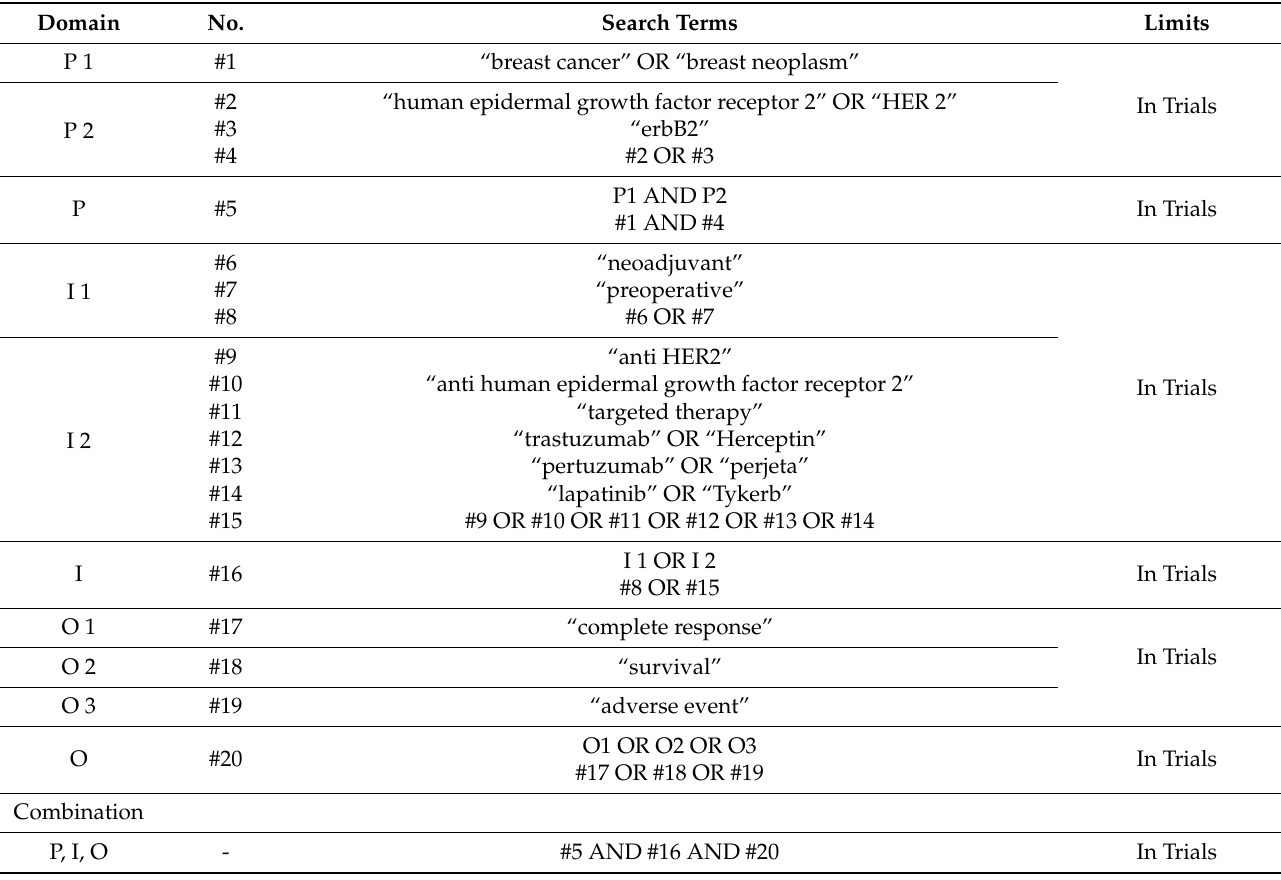
Table A3. Search terms and search strategy in Cochrane Central Register of Controlled